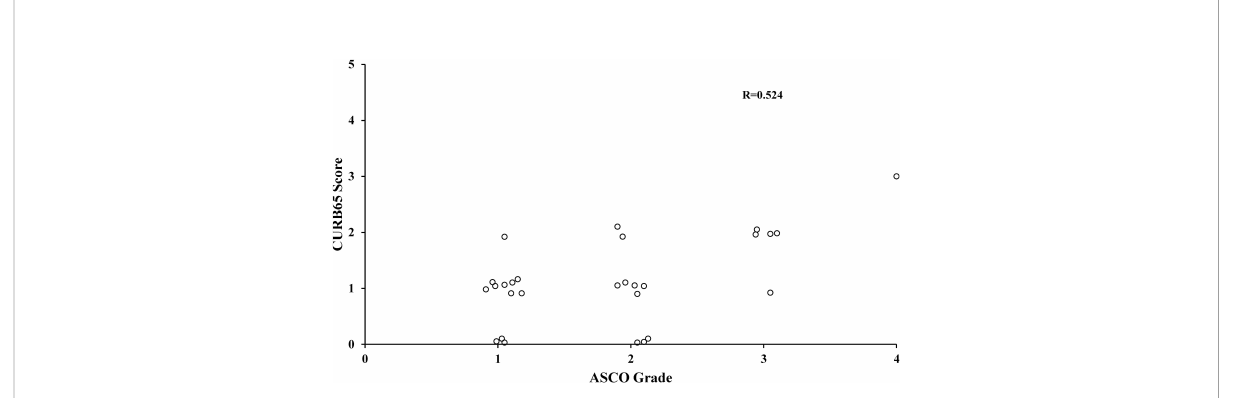
FIGURE 3 Correlation between CURB65 score and ASCO grade of CIP. The Pearson correlation analysis showed a moderately positive linear correlation between CURB65 and ASCO grade of CIP. CURB65, consciousness, urea nitrogen, respiratory rate, blood pressure and age; CIP, checkpoint inhibitor-associated pneumonitis. ASCO, American Society of Clinical